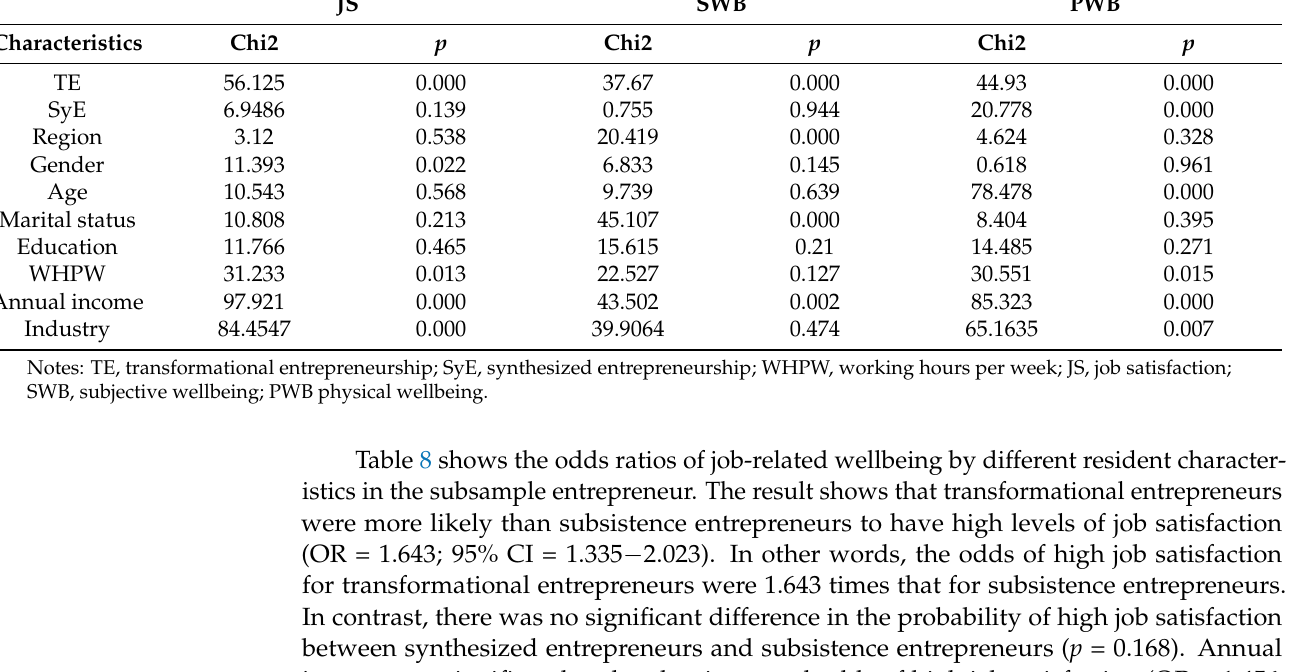
Table 7. The univariable analysis of job-related wellbeing with various factors in subsample entrepreneur. JS SWB PWB